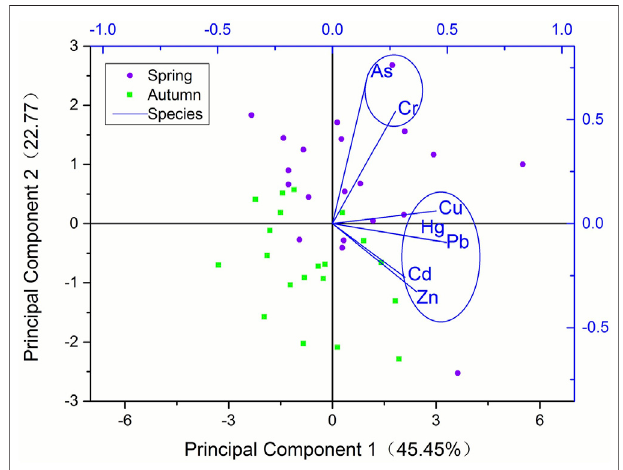
FIGURE 8 | Component scores for the fi rst two principal components (PC1 vs. PC2).